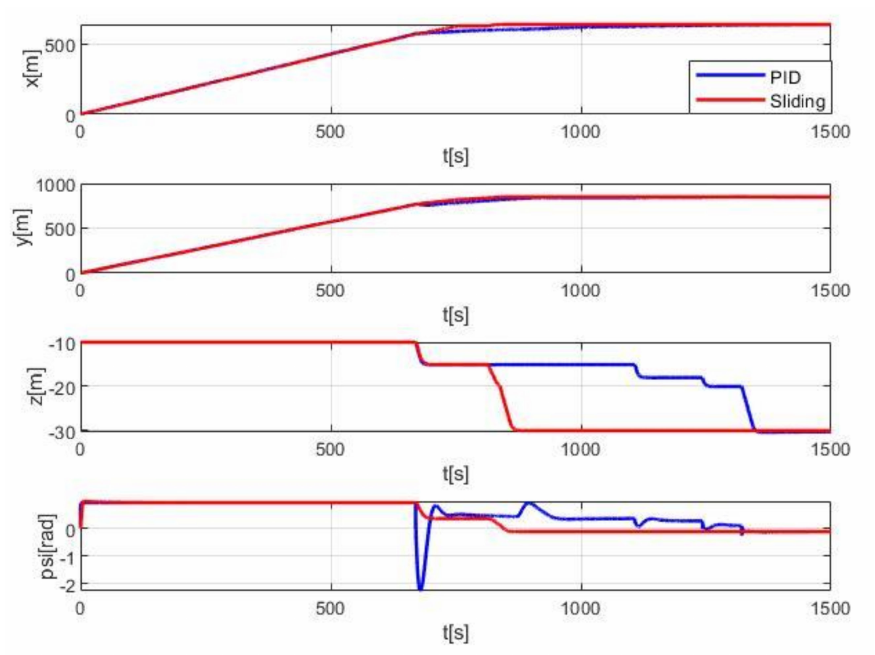
Figure 11. Time history of the position of the